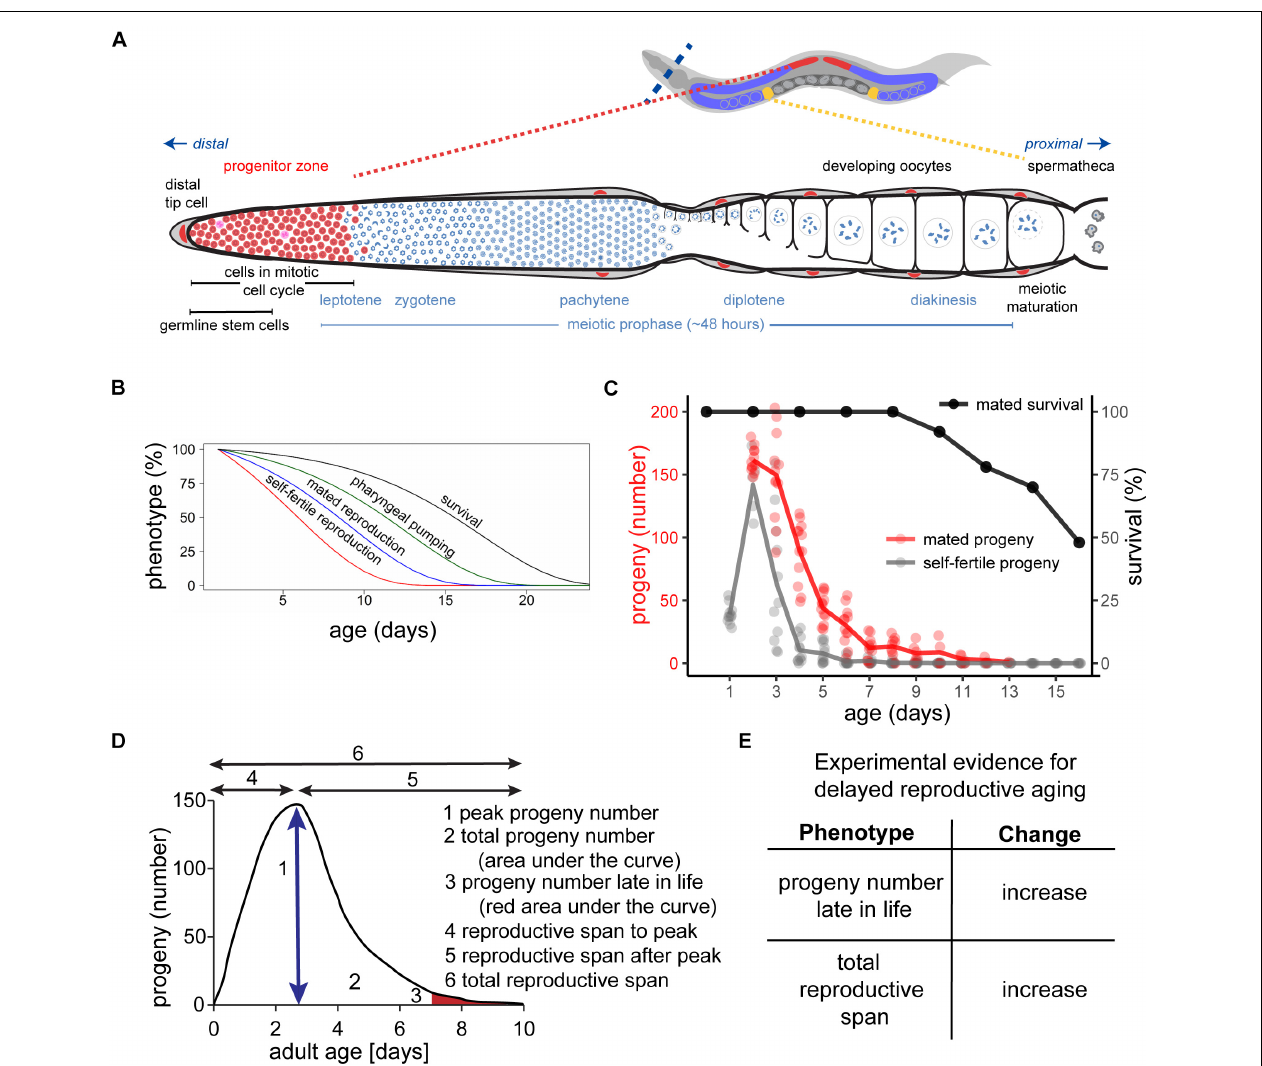
FIGURE 1 | Somatic and reproductive aging in Caenorhabditis elegans . (A) Architecture of one of the two gonad arms of a young adult hermaphrodite. At the distal end of the gonad, the somatic distal tip cell (red) is embedded in other somatic gonad cells (gray) and maintains the germline stem cell fate via GLP-1/Notch signaling. The germline stem cells (SYGL-1 positive cells) progress from the distal end of the gonad to the proximal end. During this journey, they undergo mitosis in the progenitor zone (red), progress through the meiotic prophase and meiotic maturation. Finally, they are ready to be fertilized by sperm in the spermathecal (yellow). In adults, the progenitor zone and the early prophase of meiosis I overlap. Adapted from Kocsisova et al. (2019). (B) C. elegans exhibits age-related degenerative changes of the soma and the germ line. Self-fertile reproduction (red) and mated reproduction (blue) decreases before somatic functions such as pharyngeal pumping (green), and survival (black). Adapted from Kumar et al. (2014). (C) Progeny production curves of unmated/self-fertile (gray) versus mated (red) hermaphrodites. Mated hermaphrodites survive beyond their reproductive span (black). Note that hermaphrodites that died by matricidal hatching were censored. Adapted from Kocsisova et al. (2019). (D) Summary statistics for analysis of the progeny production curve: peak egg number (arrow under the curve); total egg number (area under total curve), egg number late in life (red area under tail of curve), reproductive span to the peak, reproductive span after the peak, and total reproductive span (black arrows). (E) Experimental evidence for delayed reproductive aging in mated hermaphrodites – an increase in the total reproductive span and/or an increase in the number of eggs laid late in